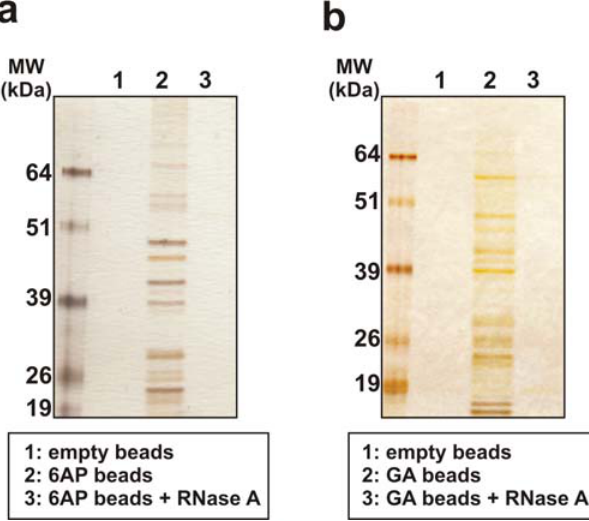
Figure 3. 6AP and GA interaction with ribosomal components is RNA-dependent. Crude yeast cell extracts were incubated with 6AP beads (left) or GA beads (right). Lane 1: control beads without 6AP or GA, lane 2: chromatography using 6AP or GA beads, lane 3: cellular extracts were treated by RNase A at 100 m g/ml for 20 minutes at room temperature before affinity chromatography experiments. The bound proteins were analyzed by SDS-PAGE followed by silver staining. Note that after treatment of cellular extracts by RNase A, ribosomal constituents are unable to bind to 6AP or GA beads, indicating that interaction between both compounds and the ribosomal constituents is RNA-dependent.